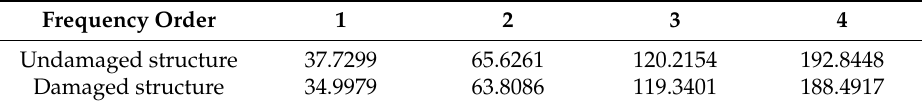
Table 5. The first four natural frequencies of the undamaged and the damaged structure/Hz.